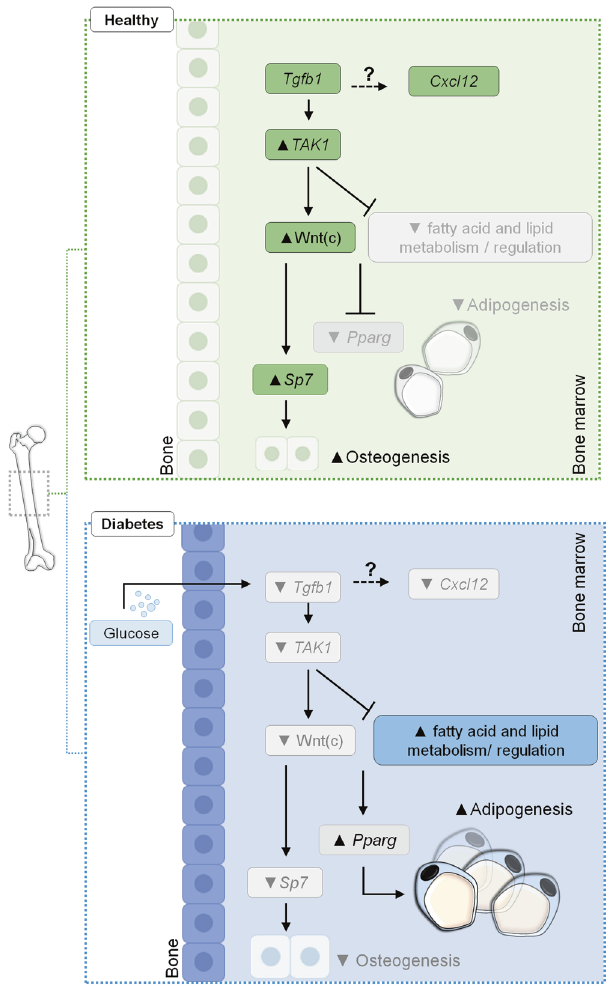
Fig. 8 Schematic illustrating the working model of diabetes-induced bone marrow dysfunction. Transforming growth factor-beta (TGFB) signaling in healthy bone tissues maintains a balance between osteoblastogenesis and adipogenesis, in collaboration through canonical Wnt signaling. At least for adipogenesis, TGFB restricts differentiation of marrow progenitor cells through the non-canonical TGFB-activated kinase 1 (TAK1) mechanism. Elevated glucose levels in diabetes suppress the TGFB signaling pathway, which, through alleviation of TAK1, leads to Pparg induction and expression of fatty acid- and lipid metabolism-regulating genes to favour adipogenesis. Dashed black arrows indicate linkages that require further